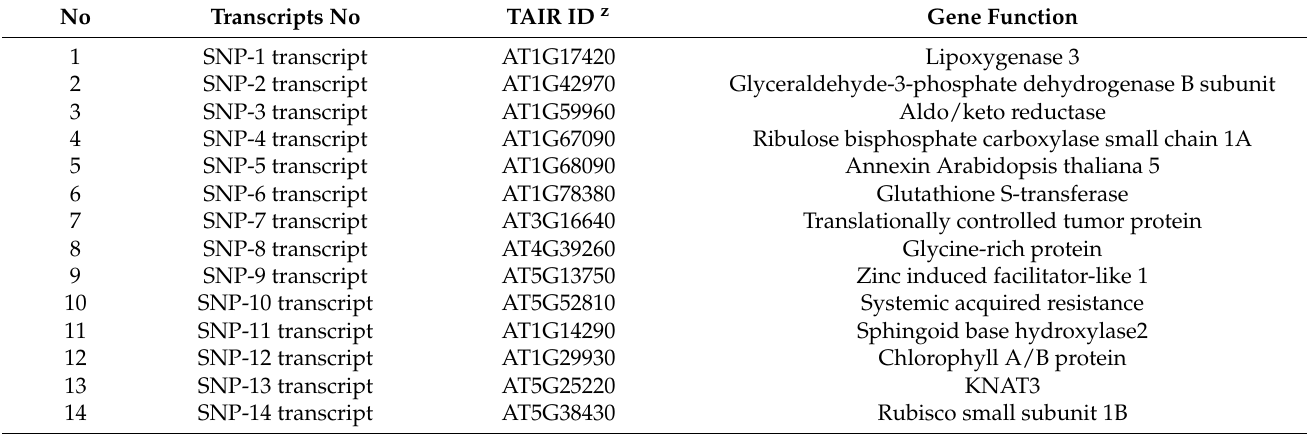
Table 2. Gene functions of 14 selected transcripts with SNPs that exist between the resistant and susceptible